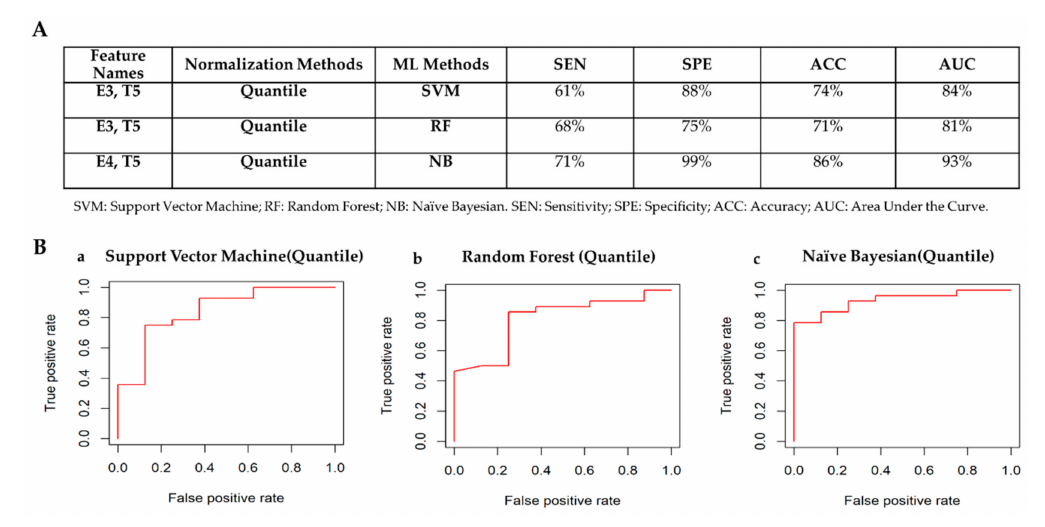
Figure 8. Classifiers’ performance to detect PR receptor status. ( A ) Comparison table among classifiers: PR + vs PR–. ( B ) ROC curves for the best classifiers to automatically detect PR receptor status. a) Best classifier for Support Vector Machine Method. The normalization methods that achieved the best performance is the quantile normalization method. b) Best classifier for Random Forest Method. The normalization method that achieved the best performance is the quantile method. c) Best classifier for Naïve Bayesian Method. The normalization method that achieved the best performance is quantile method.